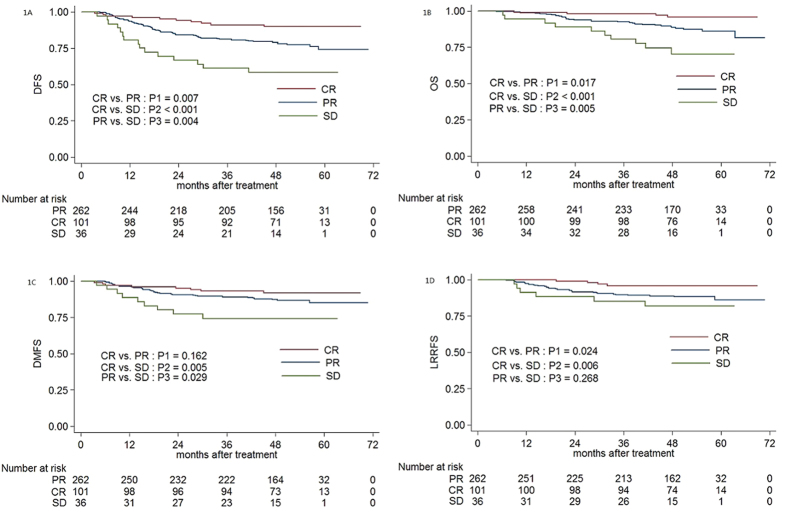
Kaplan-Meier DFS (1A), OS (1B), DMFS (1C) and LRRFS (1D) curves for 399 patients with NPC receiving IMRT stratified as the CR, PR and SD groups based on overall tumour response after induction chemotherapy. Abbreviations: DFS = disease-free survival; OS = overall survival; LRRFS = local-regional relapse-free survival; DMFS = distant metastasis-free survival. CR = complete response; PR = partial response; SD = stable disease.